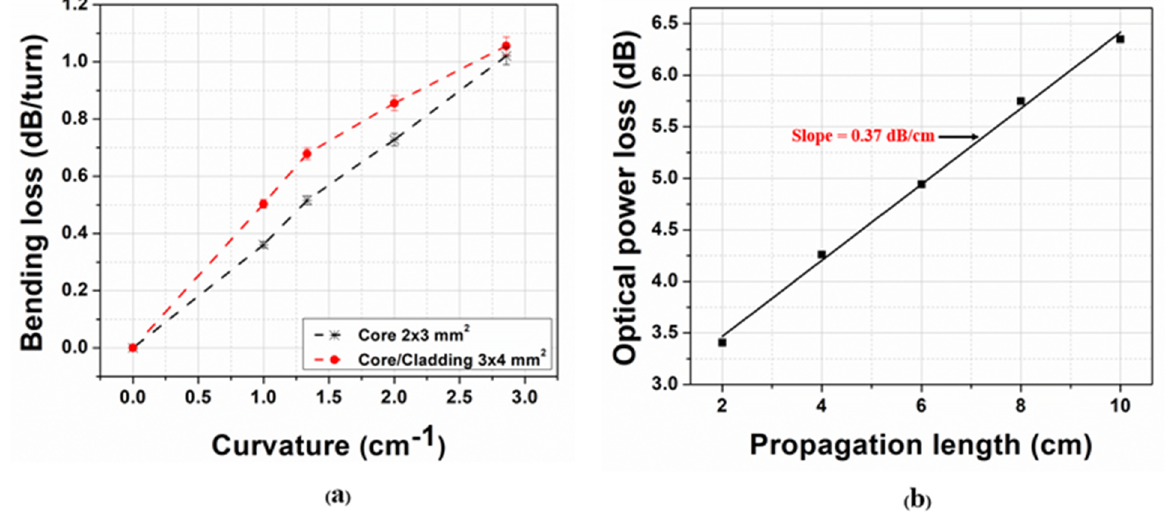
Figure 9. ( a ) Bending loss in dB/turn as a function of the radius of curvature. ( b ): PDMS-BPh waveguides (0.1%BPh/wt., core: 2 × 3 mm 2 ) propagation loss measurement with the cutback method.